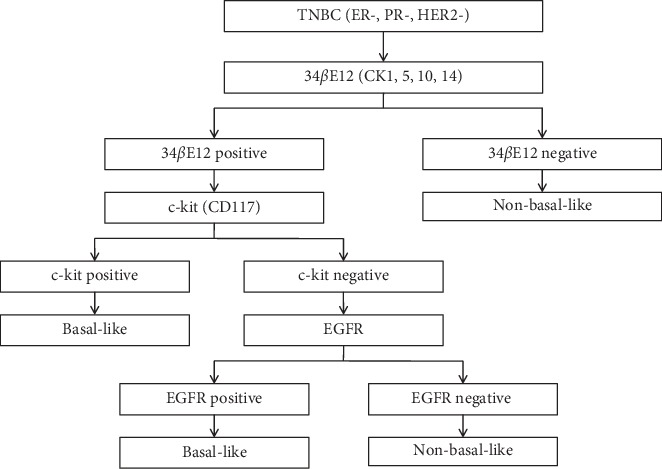
Algorithm for defining basal-like breast cancer (adopted from Nielsen et al.).